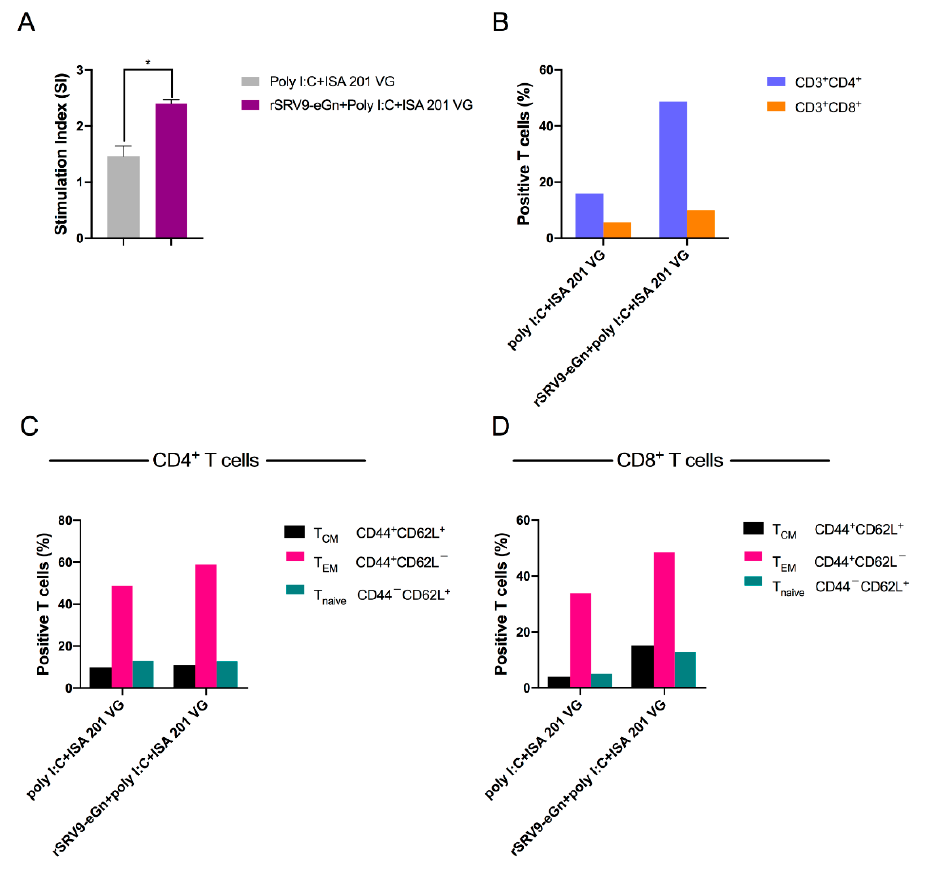
Figure 10. Antigen-specific T cell proliferation. Splenocytes from immunized mice were stimulated with the purified RVFV eGn protein for 36 h. The stimulation index (SI) of the splenocytes was detected using a CCK assay ( A ). T cell proliferation was analysed by using the following gating strategy: live → single cells → CD3 + → ( B ) CD4 + /CD8 + → ( C , D ) CD44 + /CD62L + . Central memory T cells (T CM ), effector memory T cells (T EM ) and naïve T cells (T naïve) were identified using CD44 and CD62L staining.